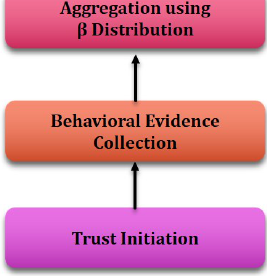
Figure 2. Trust generation